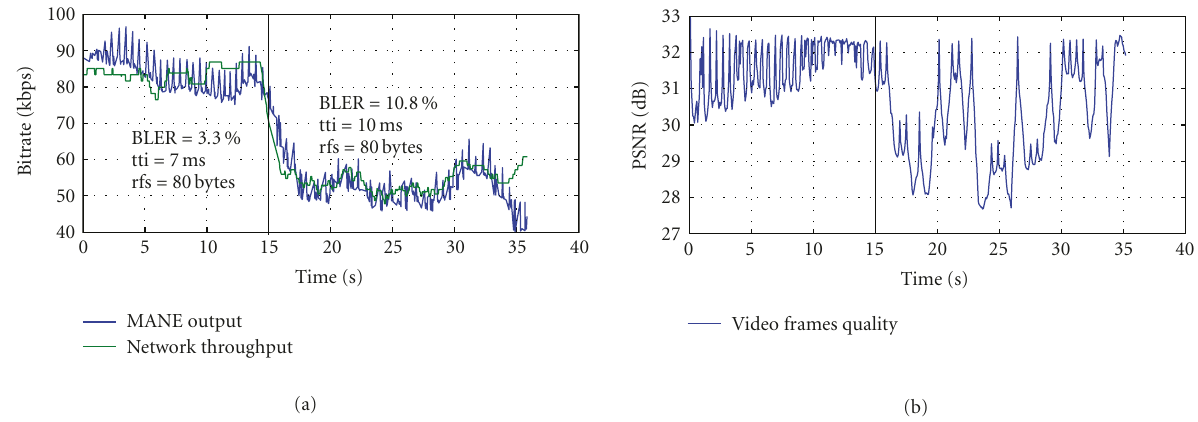
Figure 11: Bitrate adaptation with two RTP streams: quality base layer and SNR refinement layer (Paris).